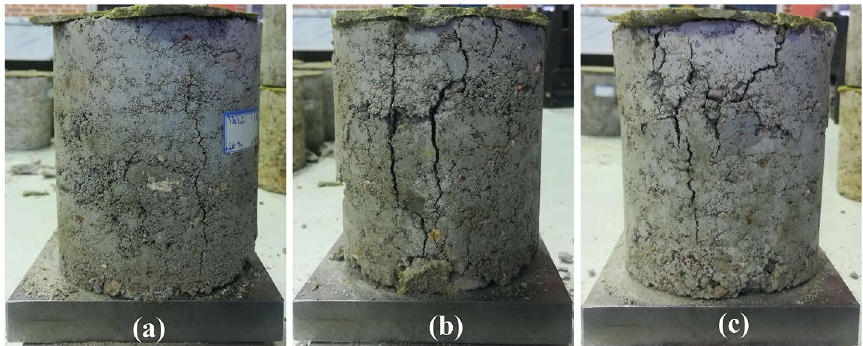
Fig. 13 The failure mode of CSG mixtures with 15% cement, cured at age 28 day and containing: a 10% bentonite (S-C15-B10 sample), b 20% bentonite (S-C15-B20 sample), c 3 0% bentonite (S-C15-B30